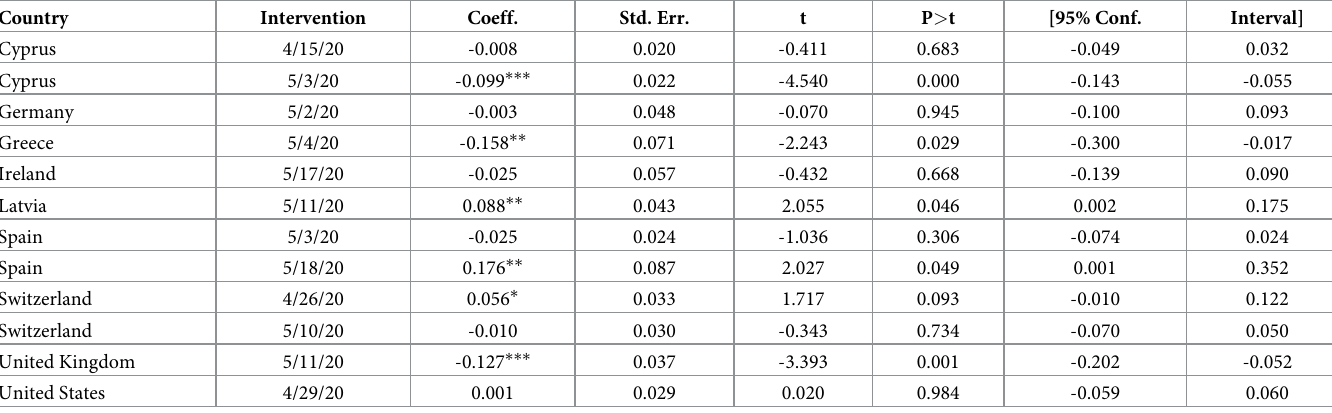
Table 1. Post-interventions linear trend with (decreasing) stringency index. Country